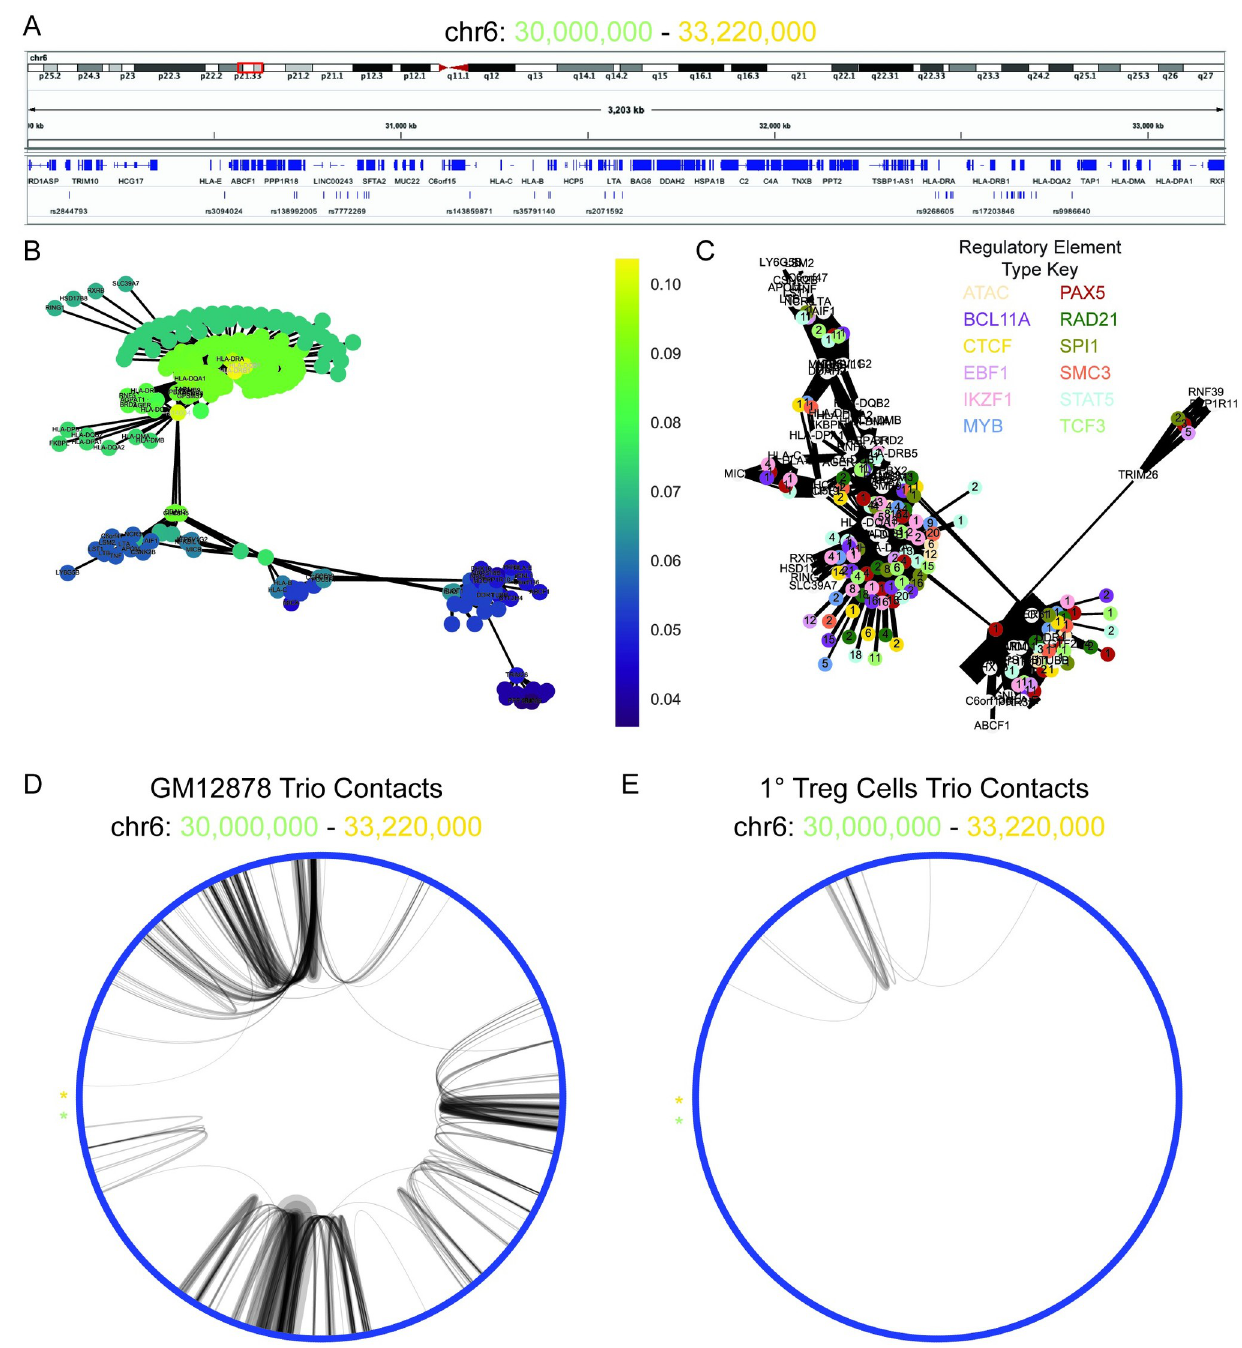
Fig 4. HLA-DRB1 and HLA-DRQ1 are top pipeline identified candidates for T1D-associated genes in the HLA locus. A: Visualization of the HLA component of interconnected pipeline genetic variant–regulatory element–gene trios (chr6: 30,000,000–33,220,000). B: Bipartite graph of the HLA component with gene and genetic variants as nodes and chromatin connections as edges. Node color indicates closeness centrality score with gold being most connected and purple being least connected nodes in the graph. Gene nodes are labeled, and genetic variant nodes are unlabeled. C: Bipartite graph of HLA component with gene and regulatory elements as nodes and chromatin connects as edges. Gene nodes are labeled and white. Regulatory element nodes are colored by type and labeled by the number of unique genetic variants contained in the regulatory element. The width of edges indicates connectivity strength as indicated by the number of unique HiChIP reads. D: Circos plot of the chromatin connectivity at 5 kb resolution in the HLA locus. The nodes are sections of the genome and the edges are the chromatin connectivity with the width indicating connectivity strength. An asterisk labels the starting (chr6: 30,000,000; green) and terminating (chr6: 33,220,000; gold) nodes of the plot. GM12878 (left panel) and Treg (right panel) pipeline trio contacts are visualized.